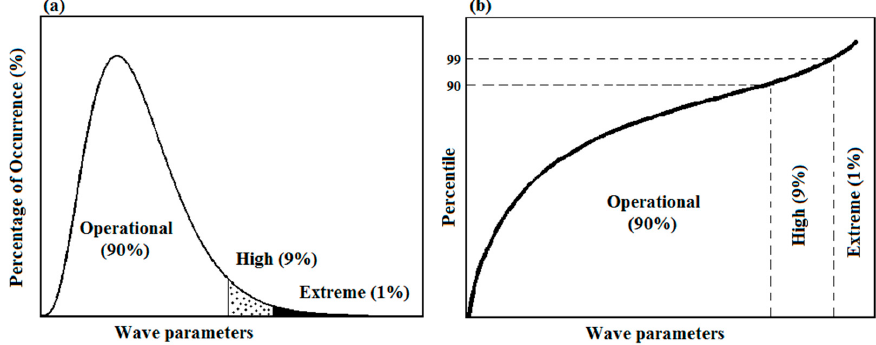
Figure 4. Graphical representation of site characterisation approach using ( a ) percentage of occurrences and ( b ) normalised wave parameters with percentiles [47].